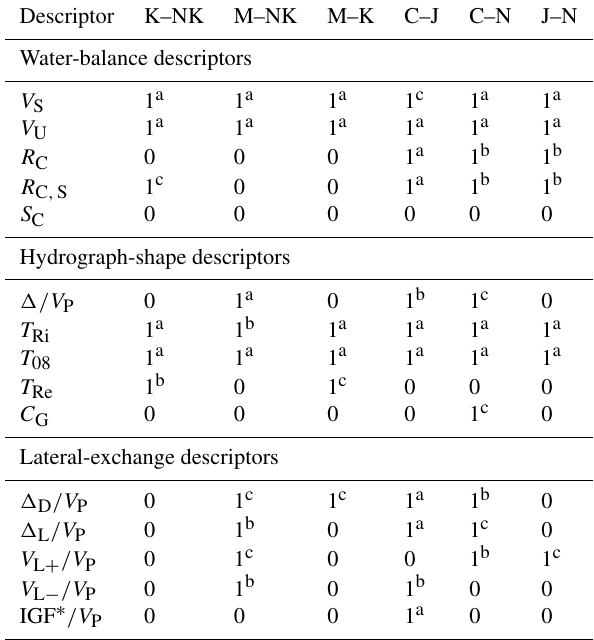
Table 2. Synthesis of t test decisions for the null hypothesis that data in paired tested samples come from independent random sam- ples from normal distributions with equal means and equal but un- known variances. The result is 1 if the test rejects the null hypothesis at the 5% significance level and 0 otherwise. The test is performed (i) in the three study areas for all combinations of paired samples by geology type (K: karst, M: mixed, NK: non-karst) and (ii) for all combinations of karst-catchment paired samples by study area (C: Cévennes, J: Jura, N: Normandy).